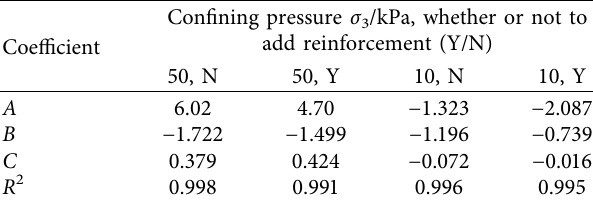
Figure 7: The relationship curve of the number of freeze-thaw cycles and the axial displacement corresponding to each freeze-thaw cycle under two stress states ((a) confining pressure of σ 3 � 50kPa; (b) confining pressure of σ 3 � 10kPa). Table 4: Values of coefficients used in equation